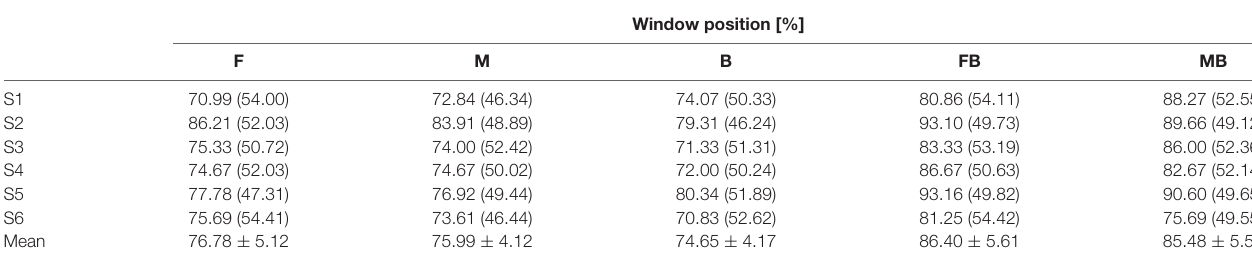
TABLE 3 | Classification accuracies for top vs. bottom.